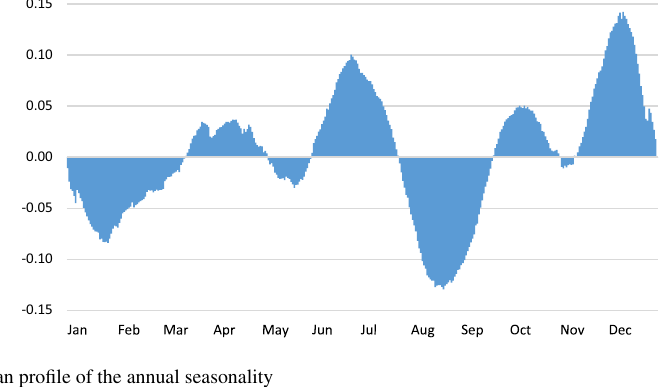
Fig. 6 Mean profile of the annual seasonality